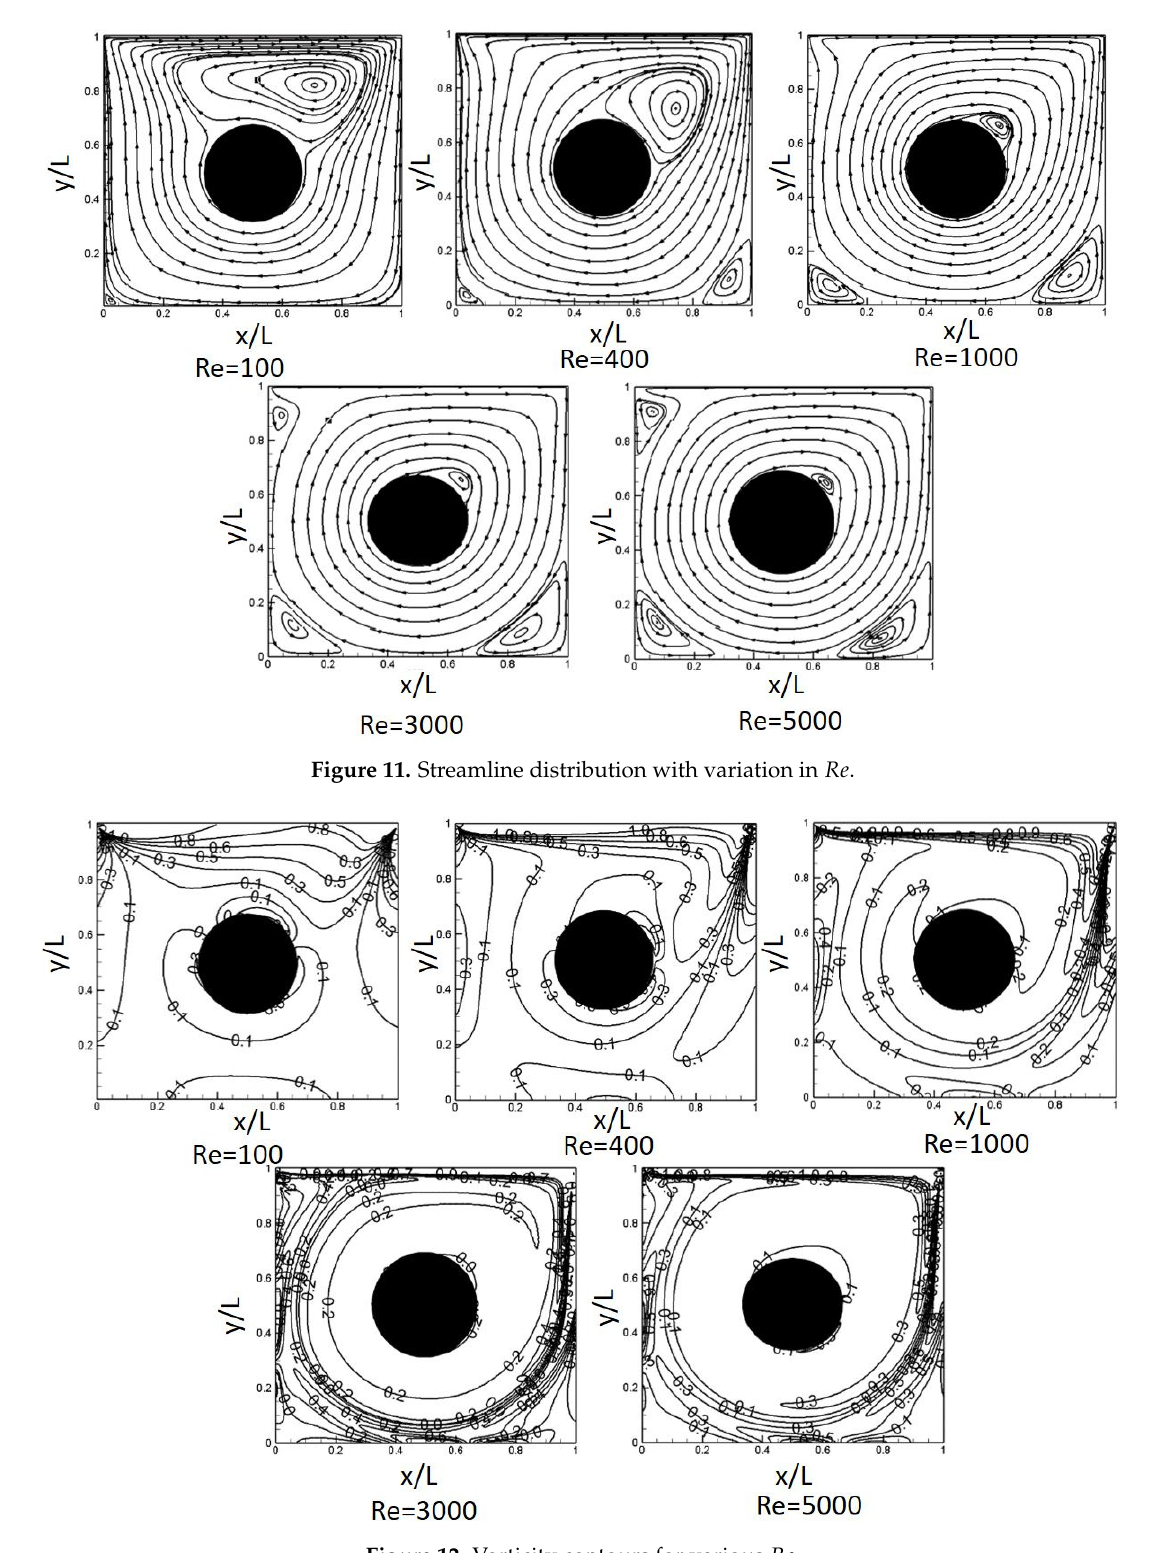
Figure 12. Vorticity contours for various Re